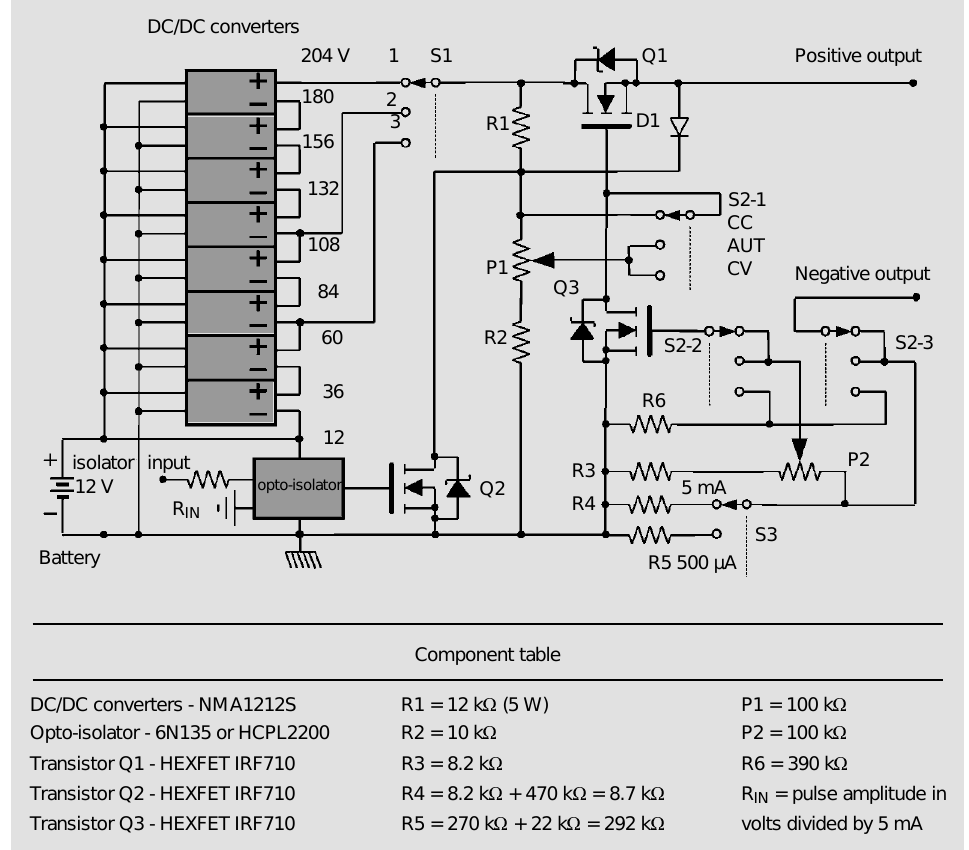
Figure 1 - HEXFET power stimu- lus isolator circuit. S1,